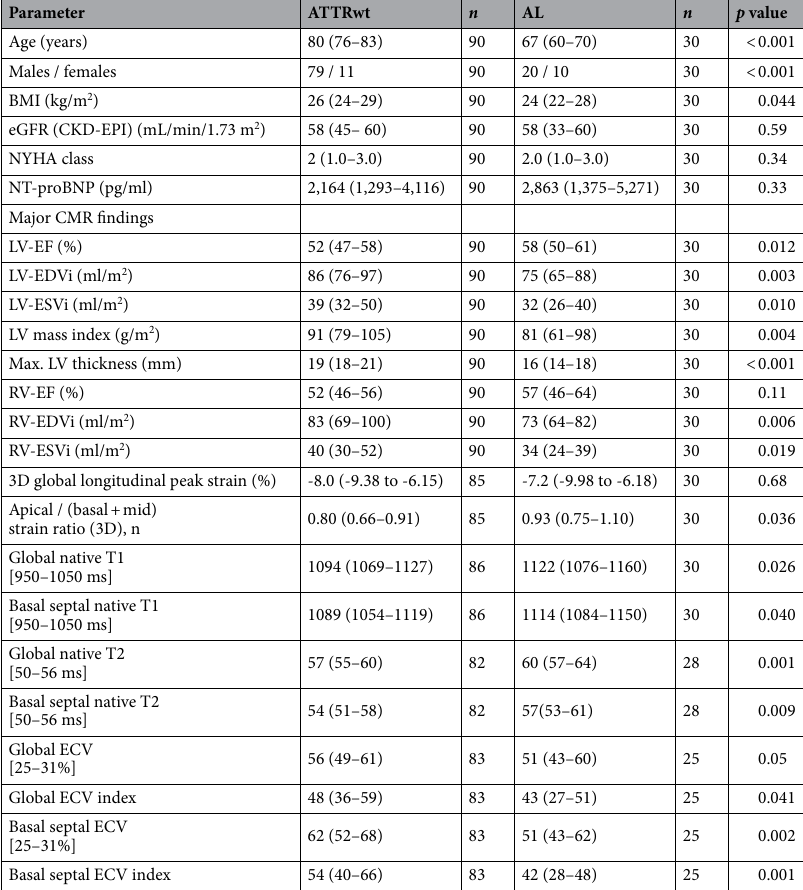
Table 1. Baseline patient characteristics of wtATTR and AL patients. All data are given as median (interquartile range), if not mentioned otherwise. Units are mentioned in small brackets (). Normal range of values are mentioned in large brackets []. BMI—body mass index; eGFR (CKD-EPI)—estimated glomerular filtration rate according—chronic kidney disease epidemiology collaboration; NYHA—New York Heart Association; NT-proBNP—N-terminal pro brain natriuretic peptides; CMR—cardiovascular magnetic resonance; LV—left ventricle; RV—right ventricle; EF—ejection fraction; EDVi—enddiastolic volume index; ECV—extracellular volume fraction, p < 0.05 is considered as significant; n = respective number of patients with available parameters.